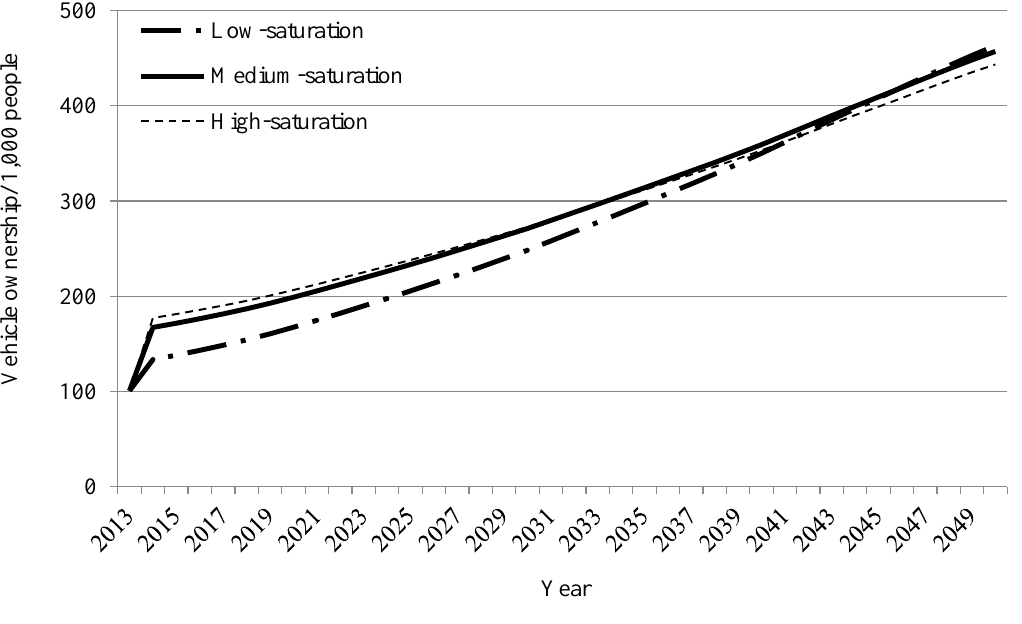
Figure 10. Sensitivity analysis of vehicle saturation level on vehicle ownership: vehicle stocks.